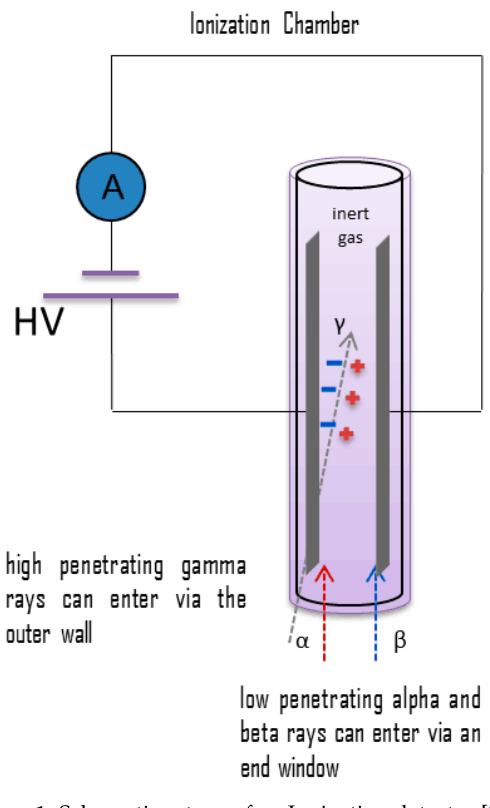
Figure 1. Schematic set-up of an Ionization detector [2,3].